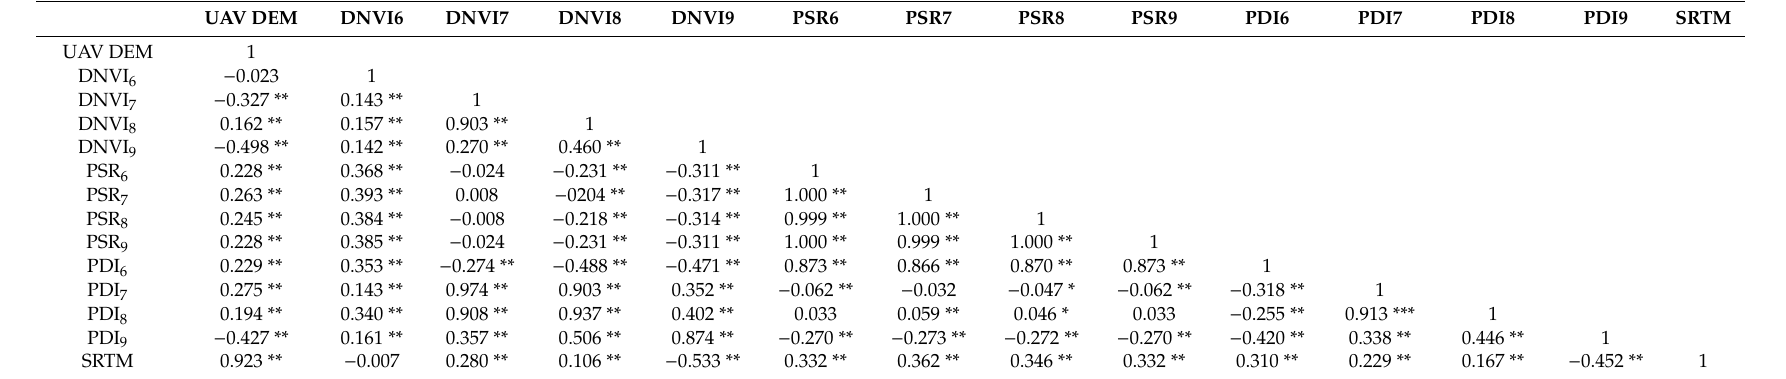
Table 3. Correlation coe ffi cient between topography and variables from June to